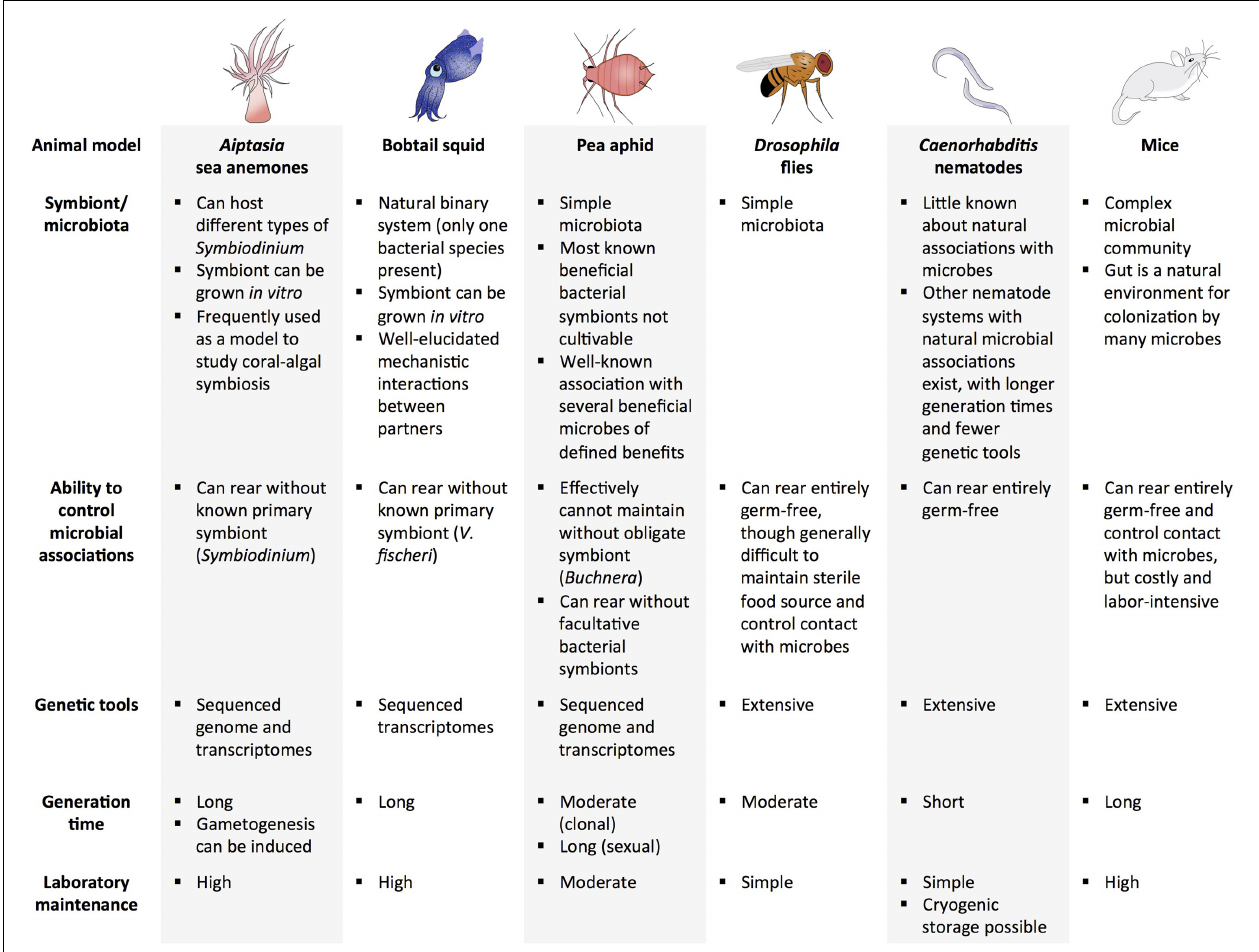
FIGURE 2 | Examples of potential animal model systems for experimental evolution of beneficial host–microbe